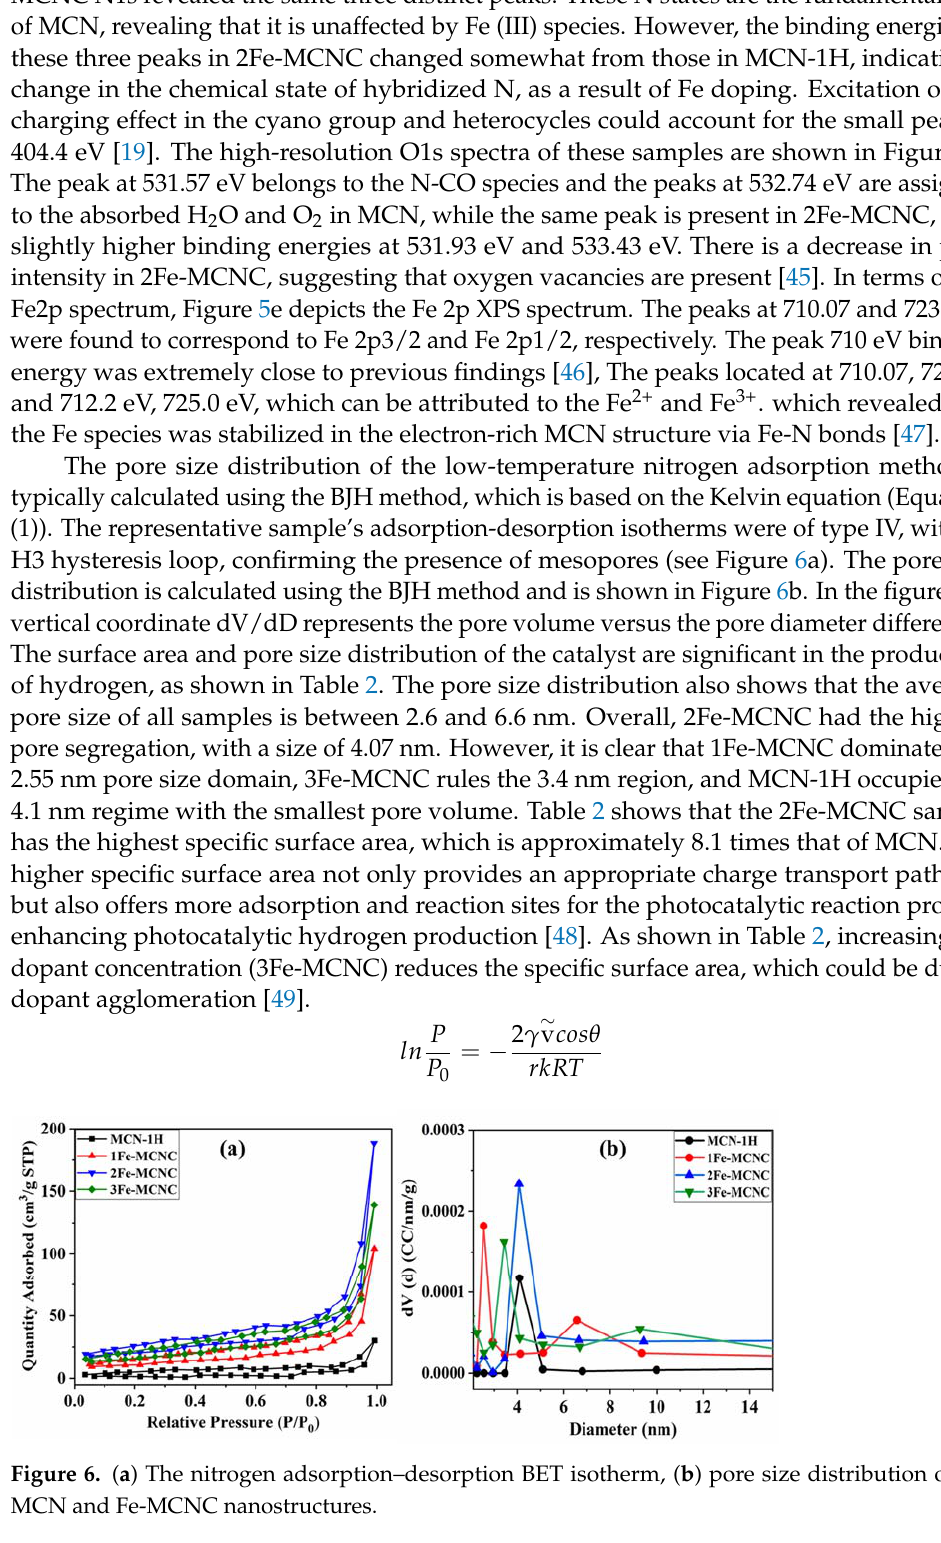
Figure 7 shows the visible minus dark (Vis ‐ dark) EPR (electron paramagnetic resonance) spectra of the MCN and Fe ‐ MCNC catalysts. Only one Lorentzian line, centered at 3380 G, with a g value of 2.004 is detected for unpaired electrons, generated in π‐ conjugated aromatic rings of carbon nitride [50]. When compared to MCN, Fe ‐ MCNC samples have a higher EPR signal intensity, indicating that the inclusion of the benzene ring significantly extended the π‐ conjugated system and boosted electron delocalization,